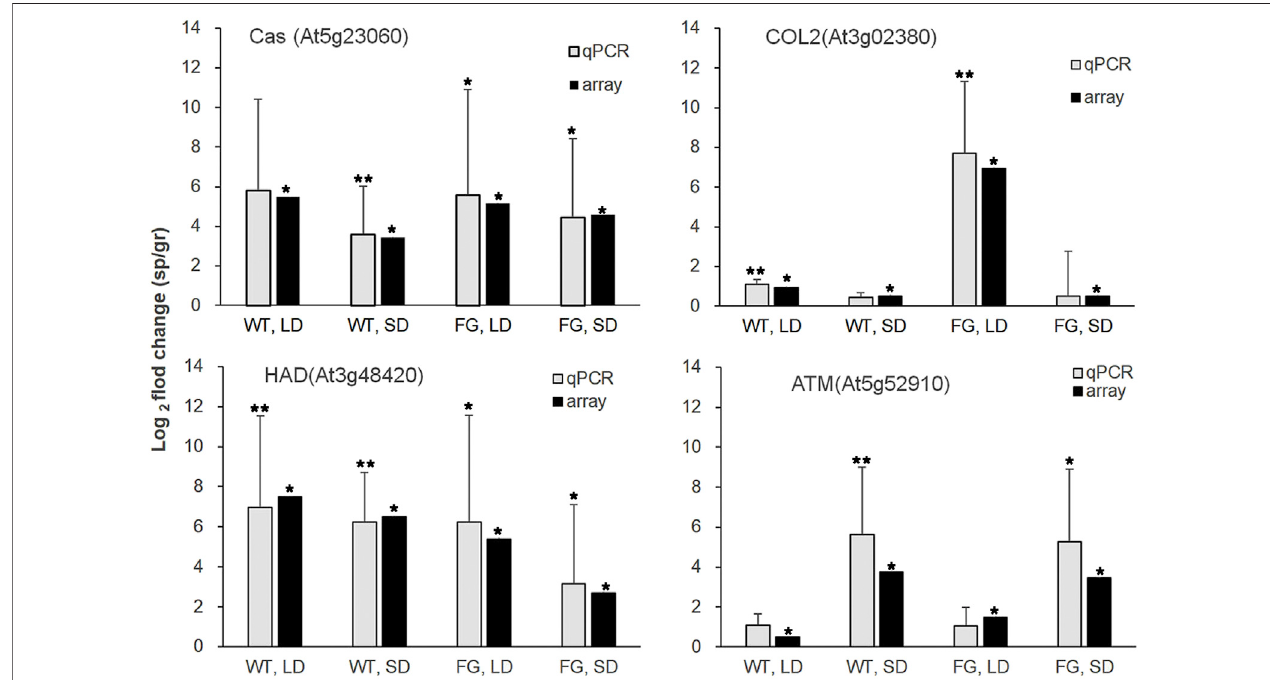
FIGURE 5 | Relative transcript abundance changes in WT and FG under LD- and SD-conditions in space (sp) in comparison with the ground controls (gr), respectively, were analyzed by microarray (array) and real-time quantitative PCR (qPCR) for Cas (At5g23060), HAD (At3g48420), COL2 (At3g02380) and ATM (At5g52910). Microarray data are shown as an average of two independent replicates, p values (* ˂ 0.05) for microarray data (the signi fi cance of differencesbetween sp and gr). qPCR with isoform-speci fi c primers ( Supplementary Table S1 ) for selected genes was performed on a third independent replicates. At3g18780 ( ACTIN ) was used as a quantitative control. Data are mean ± standard deviation, p values (* ˂ 0.05, ** ˂ 0.01, student ’ s t-test) in qPCR.